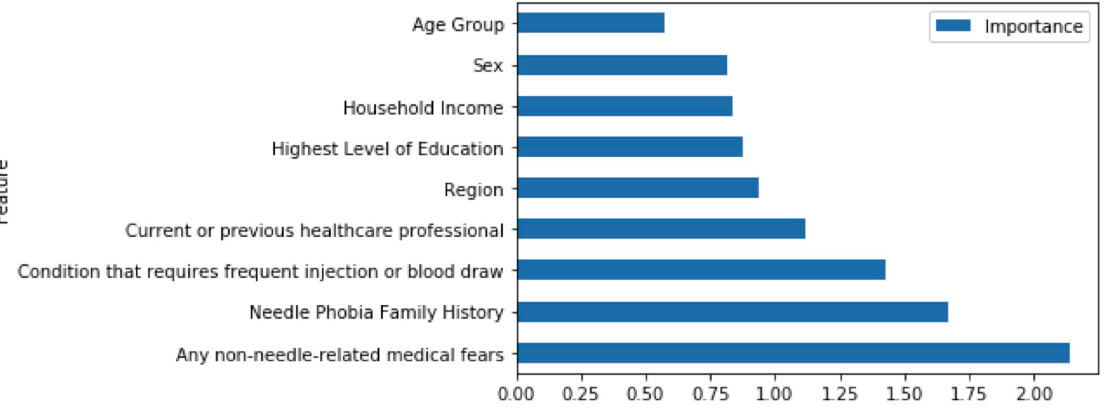
Fig 2. Feature importance (odds coefficients) bar chart for final logistic regression